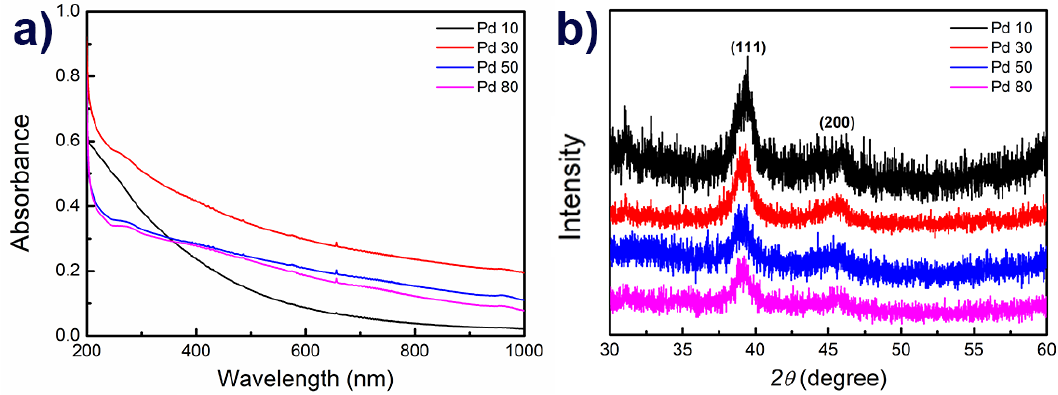
Figure 3. UV-Vis spectra ( a ) and XRD data ( b ) for the Pd NPs of Pd10, Pd30, Pd50, and